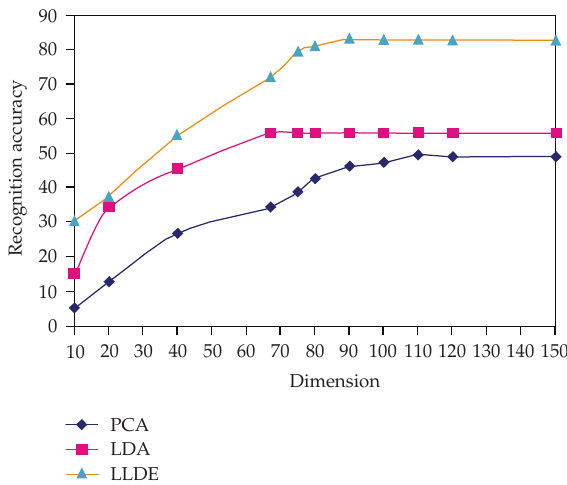
Figure 3: The recognition rates of the PCA, LDA, and